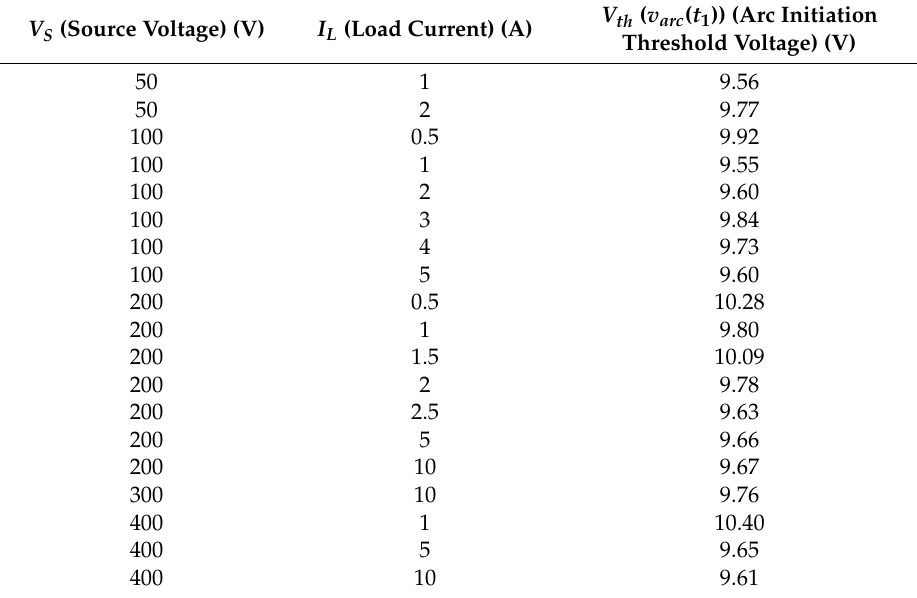
Table 2. Arc initiation threshold voltage experimental results.